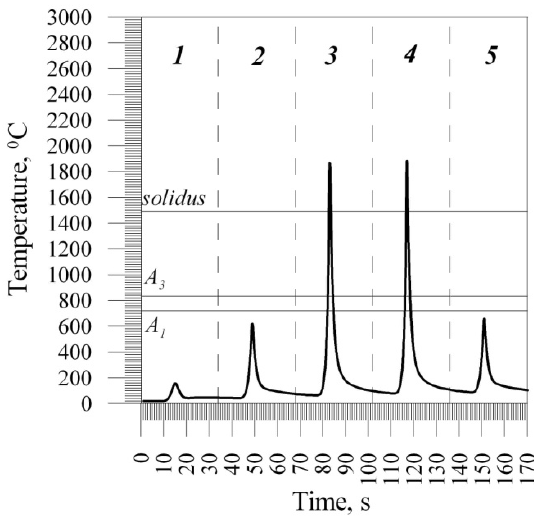
Figure 16. Heat ‐ affected zone. Figure 16. Heat-affected zone. Appl. Sci. 2017 , 7 , x